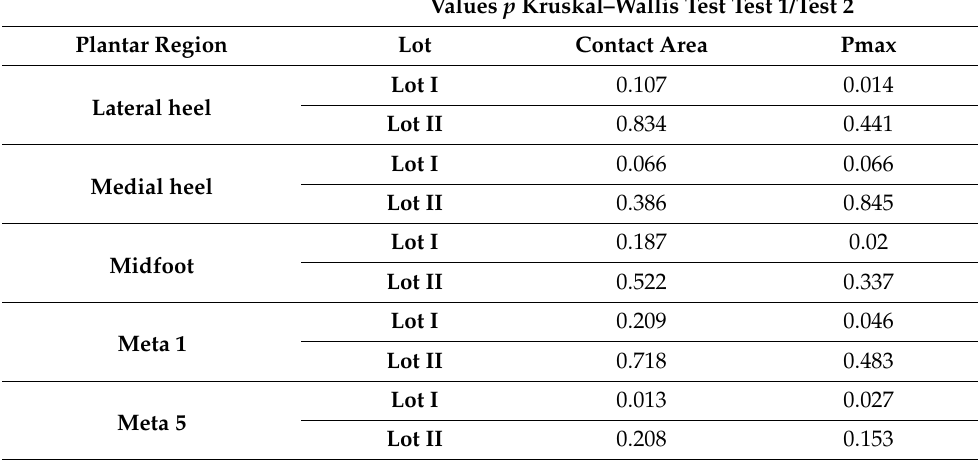
Table 8. Statistic significance of biomechanic parameters evolution of two lots, at 6 months and 1 year, to the plantar